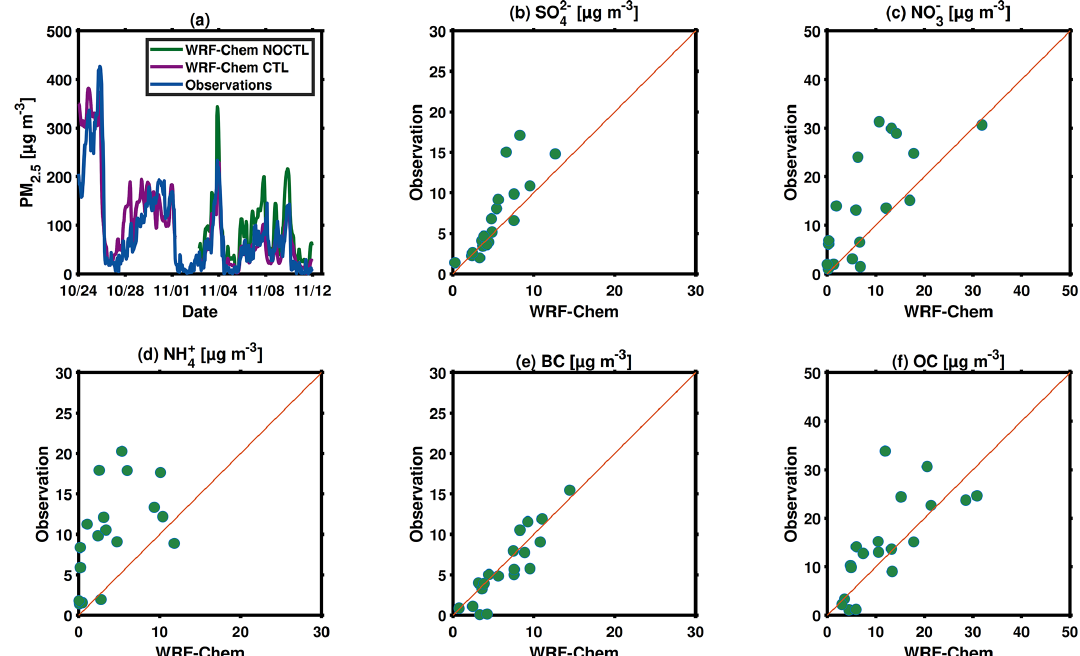
Figure 2. Modeled and observed time series of PM 2 . 5 concentrations in urban Beijing (a) ; Scatter plots of modeled and observed near-surface daily mean concentrations of sulfate, nitrate, ammonium, BC (black carbon), and OC (organics) in Beijing (b–f)